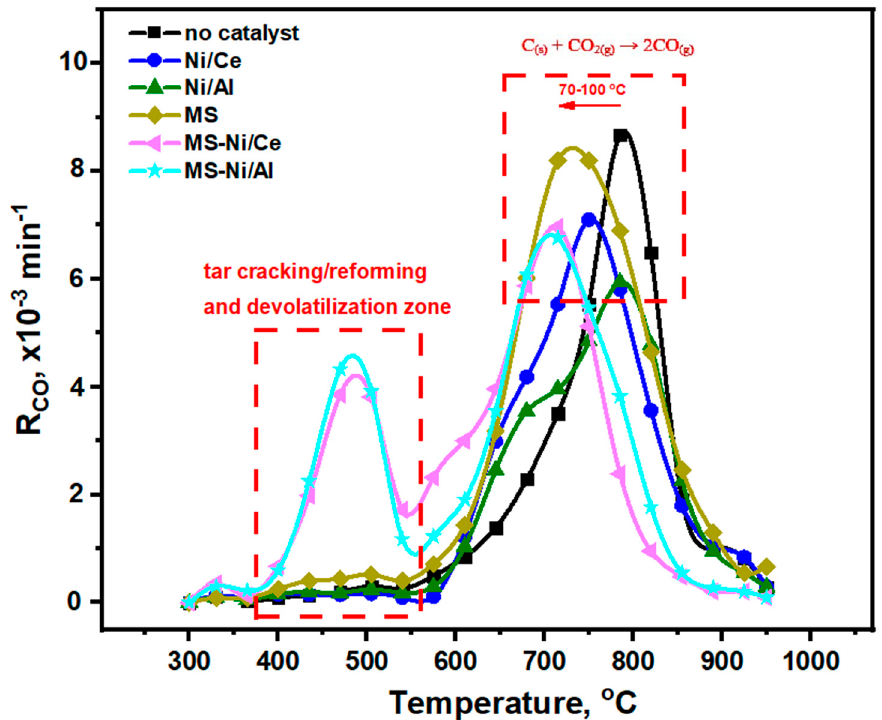
Figure 5. Effect of temperature and catalyst addition on the instant CO production rate (R CO ) during non-isothermal CO 2 gasification experiments. Gasifying agent flowrate = 30 cm 3 /min of 20 vol.% CO 2 in Helium.